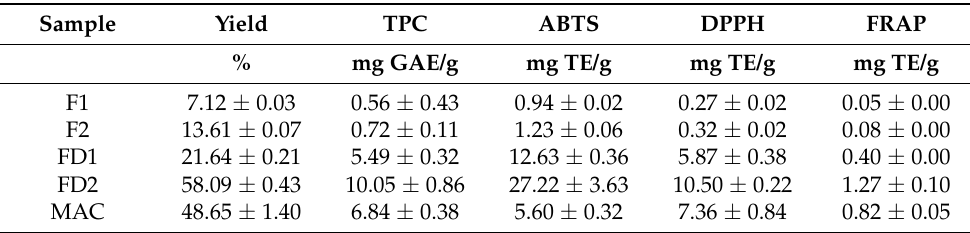
Table 1. Values of yield (%), total phenol content and antioxidant activity (ABTS, DPPH, and FRAP) of fresh and freeze-dried apple pomace, extracted once or twice by ultrasound-assisted extraction (mean values ± SD, n =